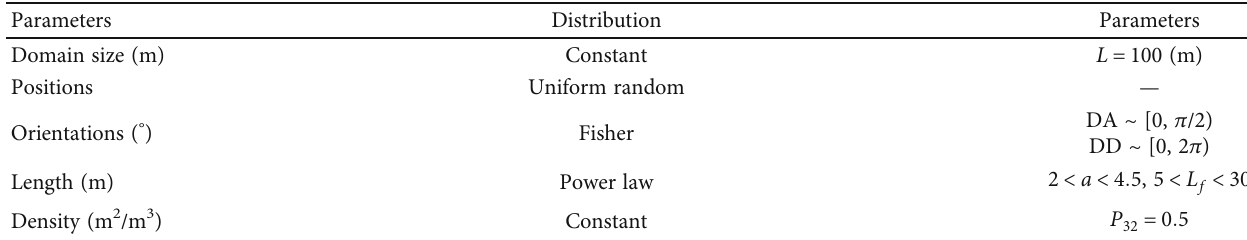
Table 2: Parameters used for the generation of